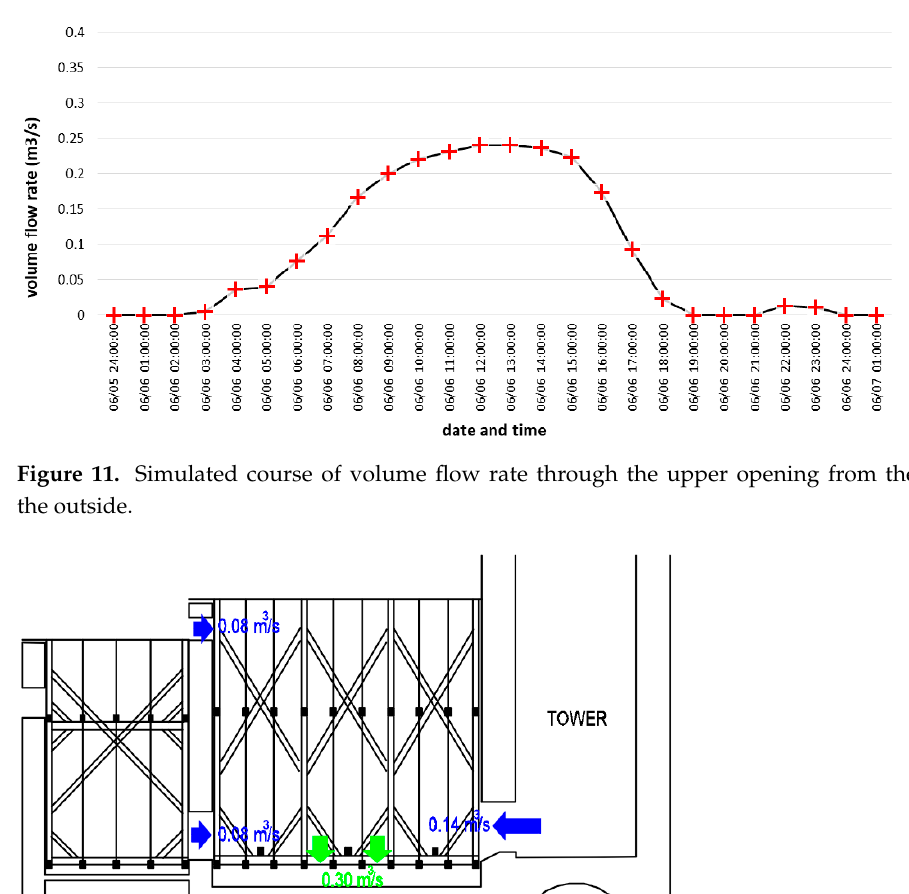
Table 6. Surface temperatures at 6:00 p.m. obtained from BPS simulation.